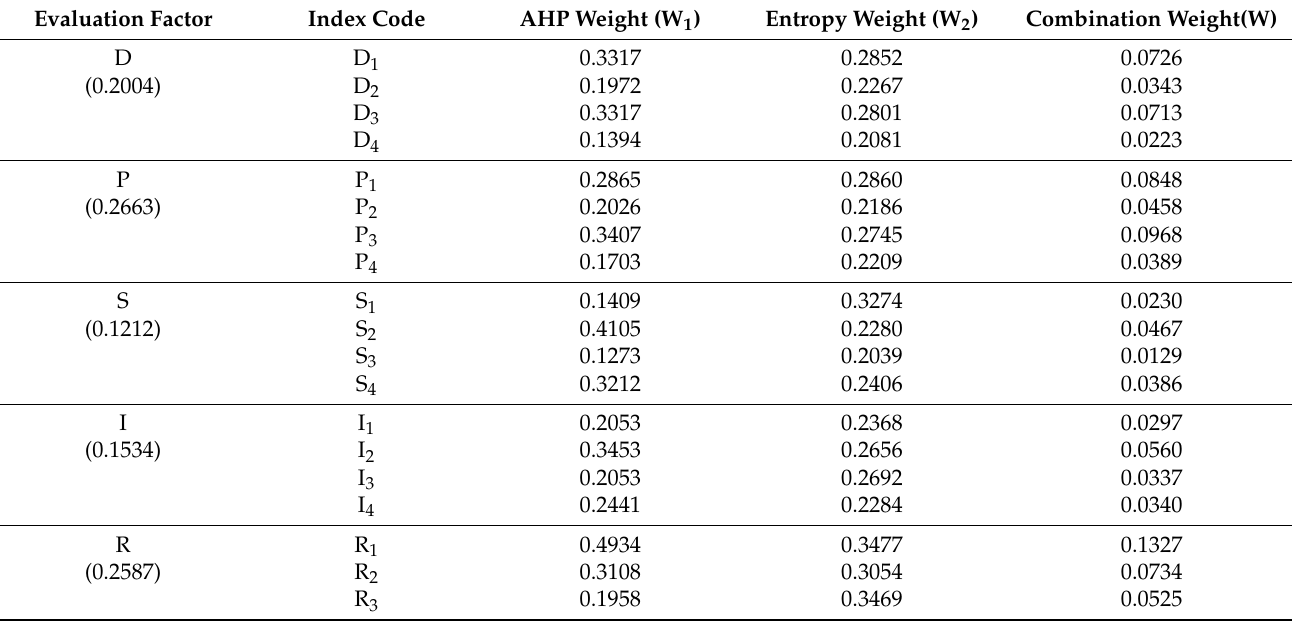
Table 3. Comprehensive weight results of the index